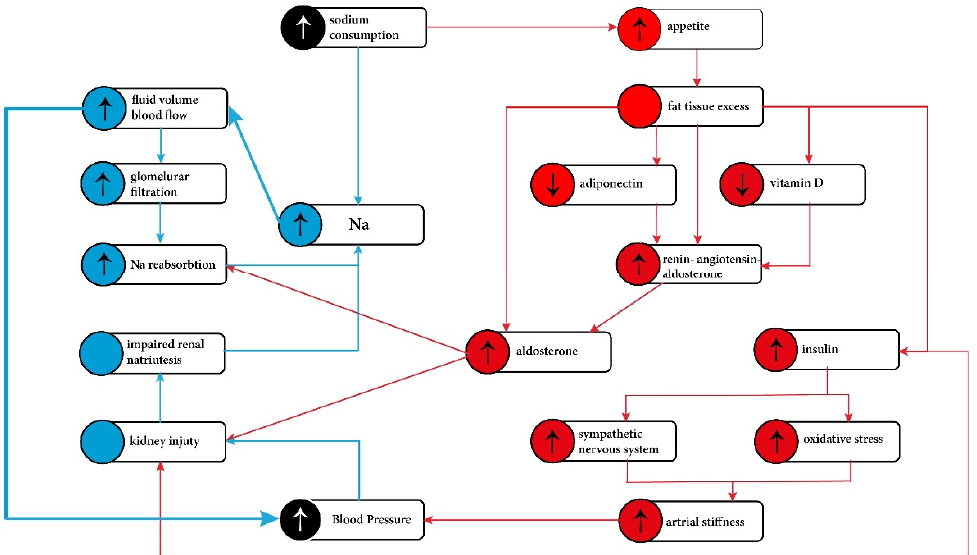
Figure 1. Pathophysiological mechanisms of the hypertension development in obese individuals. Blue—‘traditional pathway’. Red—new concepts involving fat tissue role. The traditional pathway was directed to the kidney and impaired sodium excretion. It is now known that the mechanism of the development of arterial hypertension in obesity is more complex and is associated with excess adipose tissue and abnormal adipocytes function.